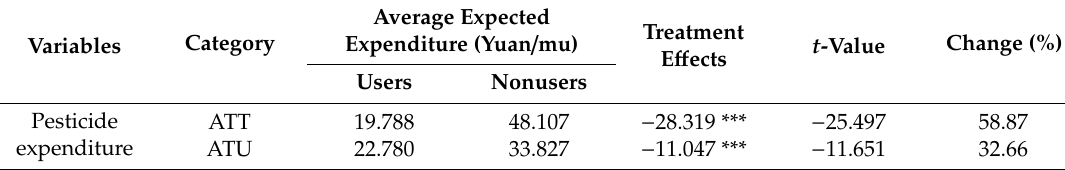
Table 4. Impact of farm machine use on pesticide expenditure: endogenous switching regression (ESR) model